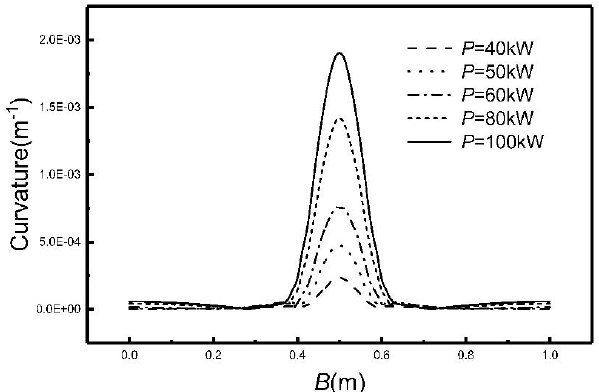
Figure 16. Transversal curvatures for different input